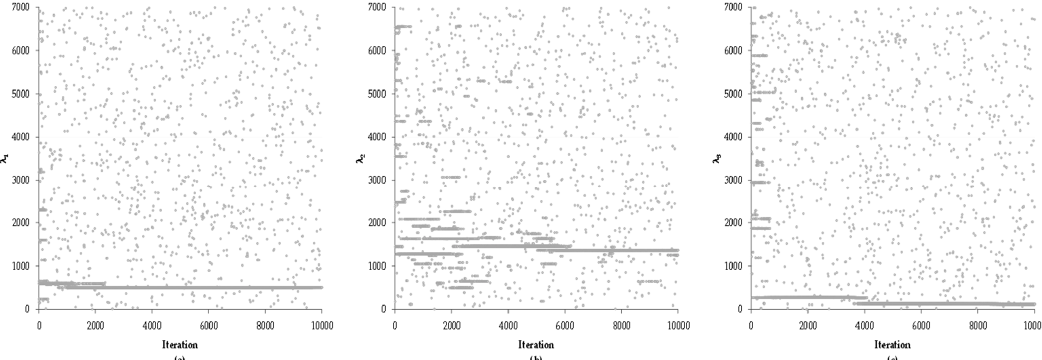
Figure 7. Behavior of the location parameters for the EV1-3P with respect to the iterations of ( a ) ε 1 ; ( b ) ε 2 ; and ( c ) ε 3 for hydrometric station 10040.